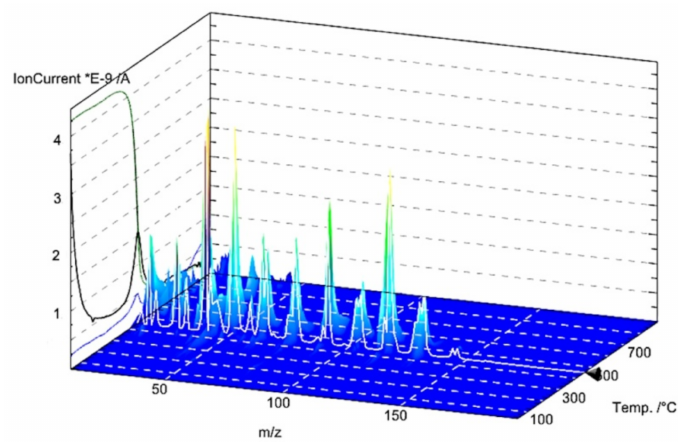
Figure 10. 3D MS profile registered during decomposition of pure DVB:TEVS = 1:1.